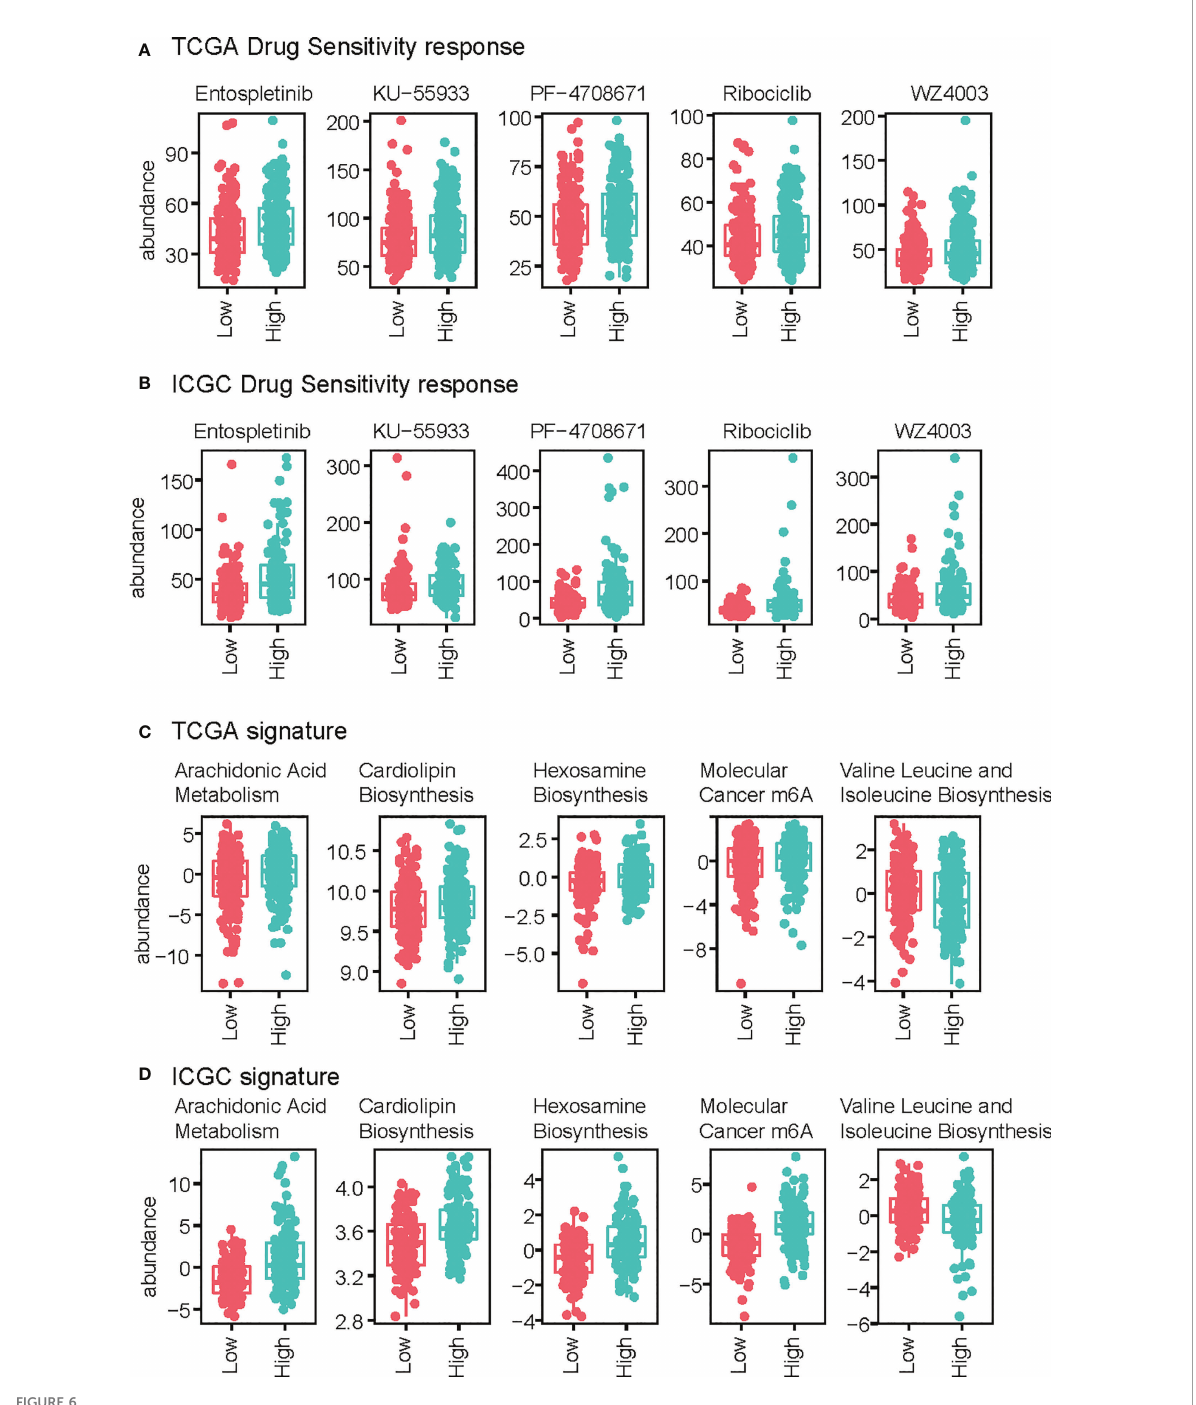
FIGURE 6 Comparison of drug response and signature score between high-risk and low-risk groups. (A, B) Drug response of the TCGA (A) and ICGC (B) datasets. (C, D) Signature scores of TCGA (C) and ICGC (D)